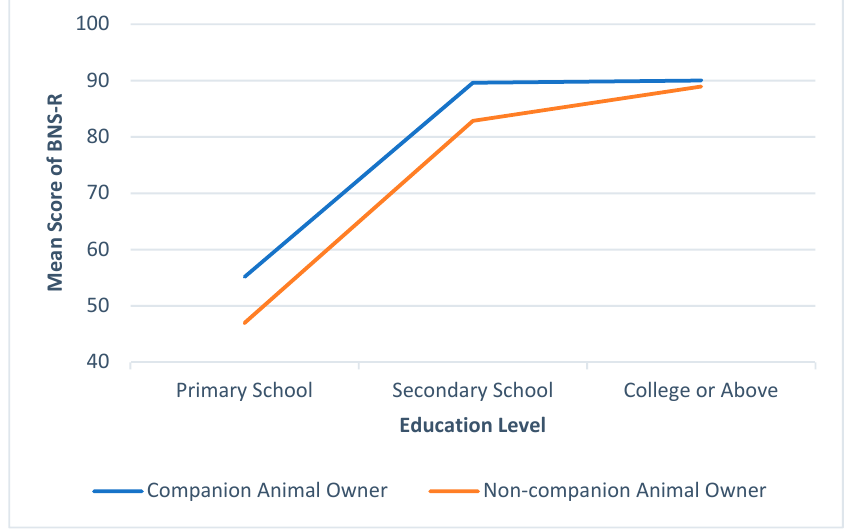
Table 7. ANOVA of impact of ownership and education level on BNS-R.